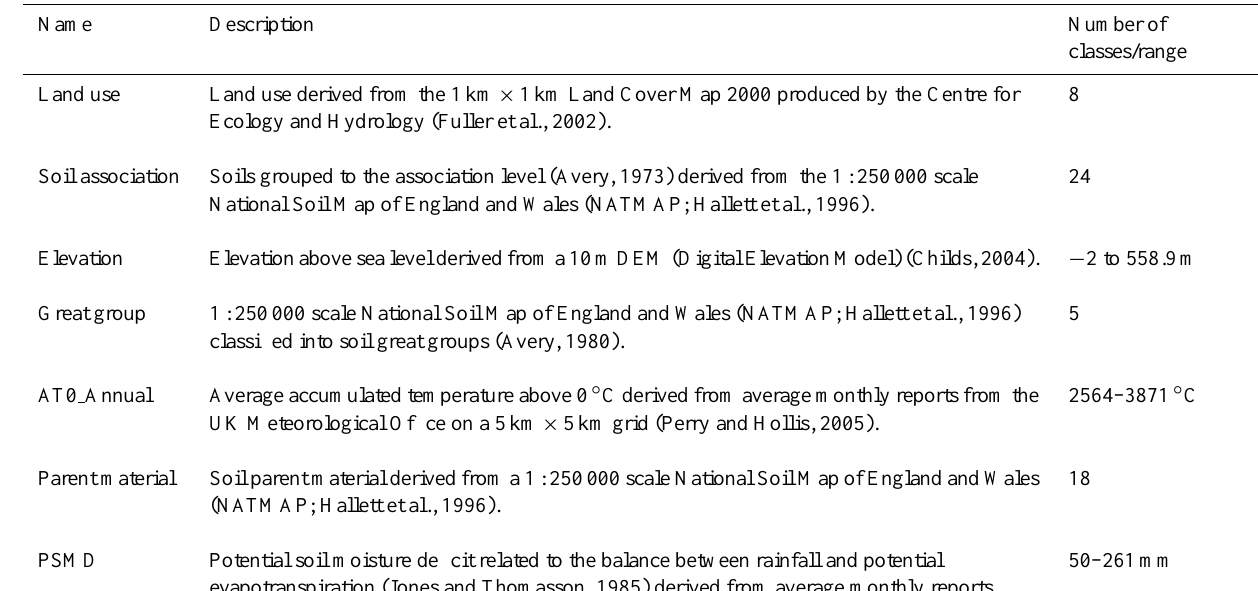
Table 1. Predictor variables used in the ANN and RF models. The variables are listed in order of importance for the RF model predicting A horizon D b